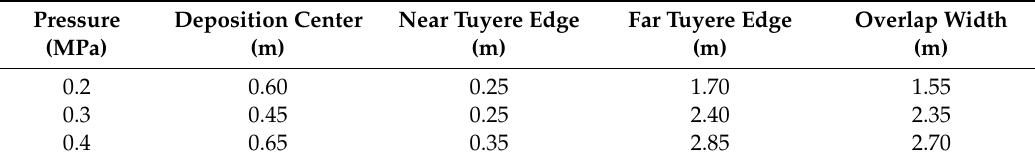
Table 4. Droplet drift distance of deposition center, near tuyere edge, far tuyere edge, and overlap width under different pressure, 0.2 MPa, 0.3 MPa, and 0.4 MPa.